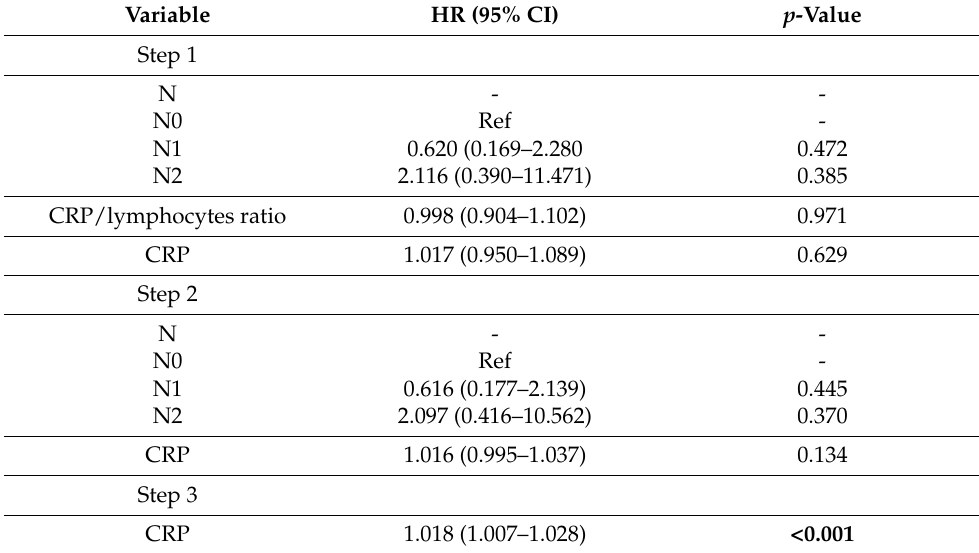
Table 6. Multivariate analyses of prognostic factors for overall survival—T2DM